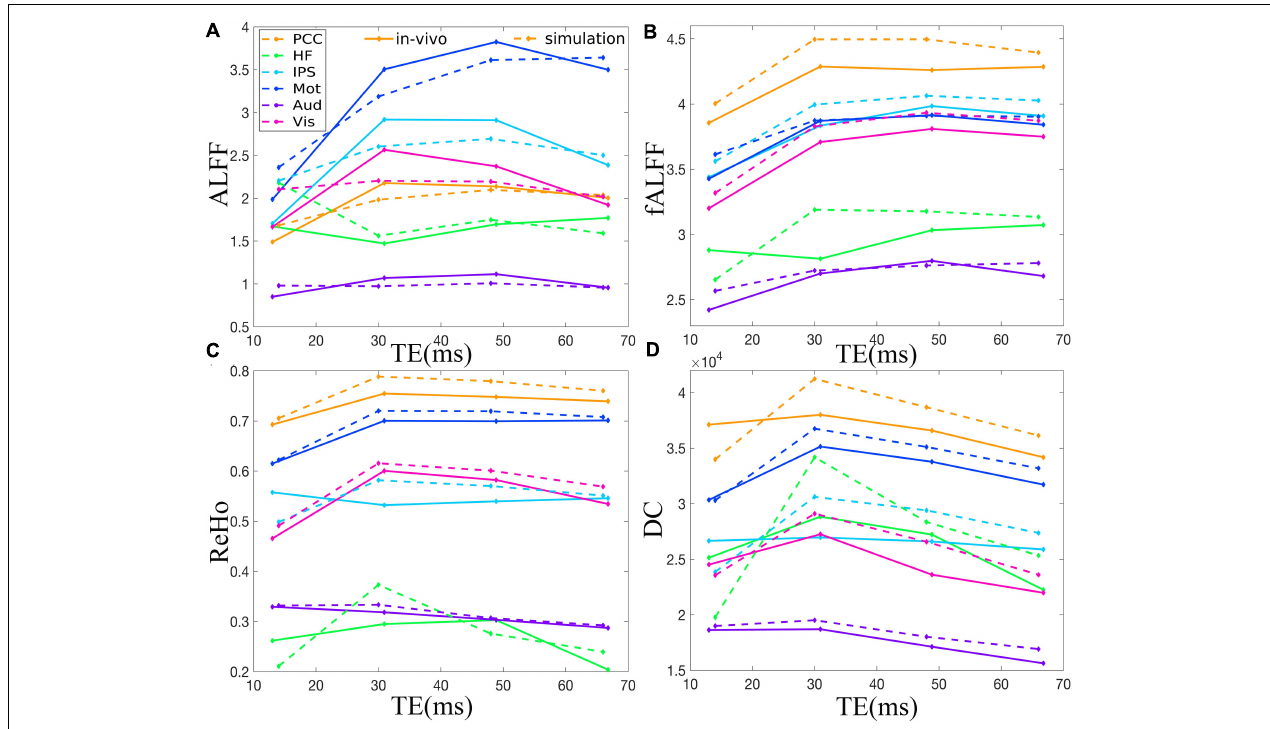
FIGURE 3 | Comparison between simulation and in vivo value of ALFF (A) , fALFF (B) , ReHo (C) , and DC (D) of six representative ROIs from a dataset with EC, i.e., PCC, HF, IPS, Mot, Aud, and Vis. The solid and dotted lines denote the in vivo and simulation results, respectively. ALFF, amplitude of low-frequency fluctuation; fALFF, fractional ALFF; ReHo, regional homogeneity; DC, degree centrality; ROIs, regions of interest; PCC, posterior cingulate cortex; HF, left hippocampal formation; IPS, left intraparietal sulcus; Mot, left primary motor cortex; Aud, left auditory cortex; Vis, left primary visual cortex.